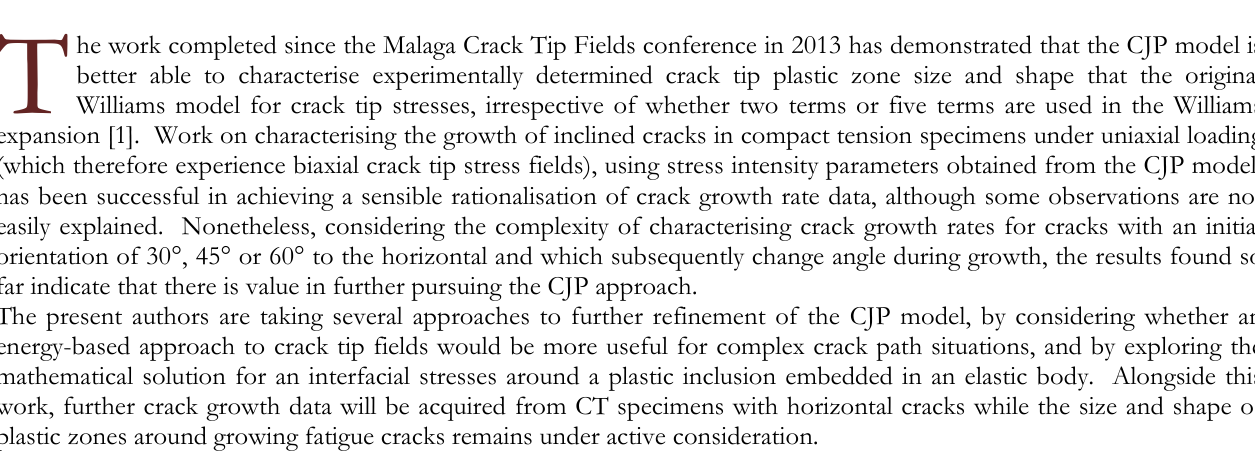
Figure 6: Reduction in scatter obtained by using the net vector sum driving force, expressed as a stress intensity factor. C